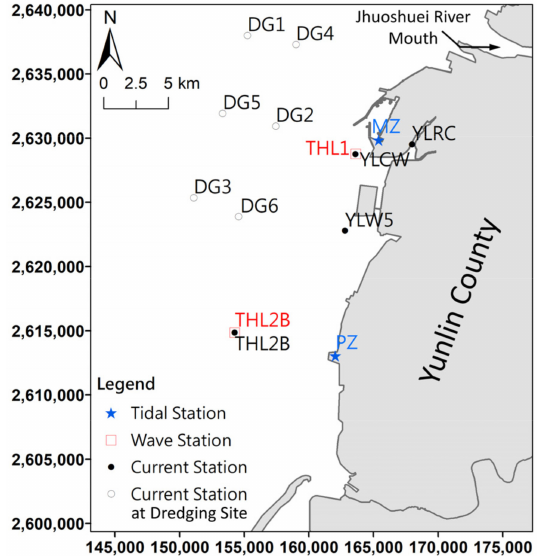
Figure 3. Location of tidal wave and current stations.